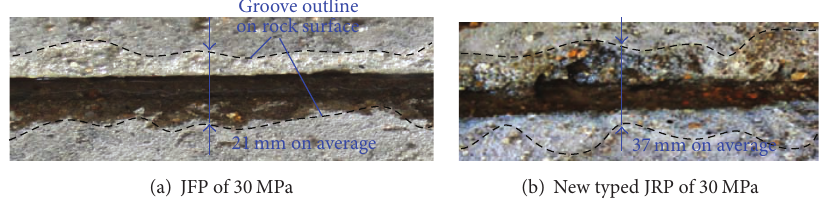
Figure 10: Grooves formed in the cutting process.